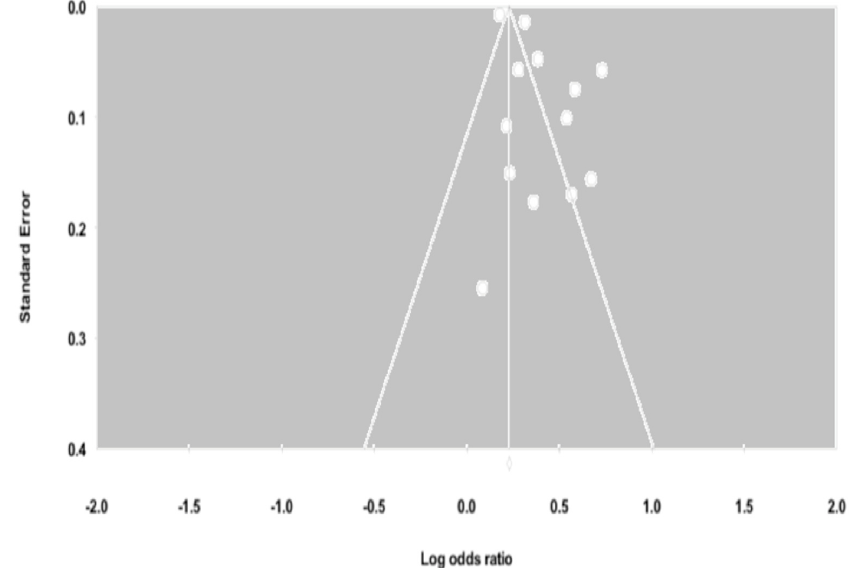
Figure 4. Funnel plots of the meta-analysis of published studies. Each point represents the log odds ratio and the standard error for a single study. The triangle represents the region where 95% of the data points would lie in the absence of a publication bias. The vertical line represents the average log odds ratio found in the meta-analysis.